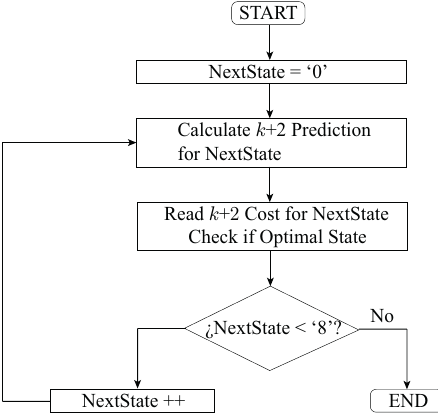
Figure 6. Flowchart of the Sequential FPGA Implementation for the